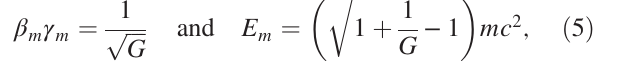
> 0 points y < 0 points toward the ring x